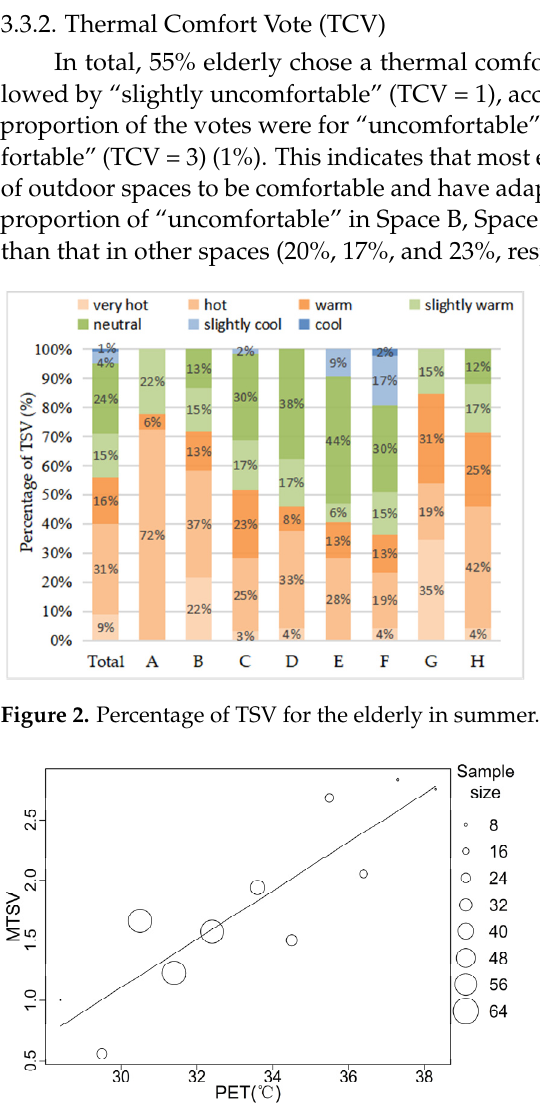
Figure 3. Correlation between MTSV and PET of the elderly in summer.